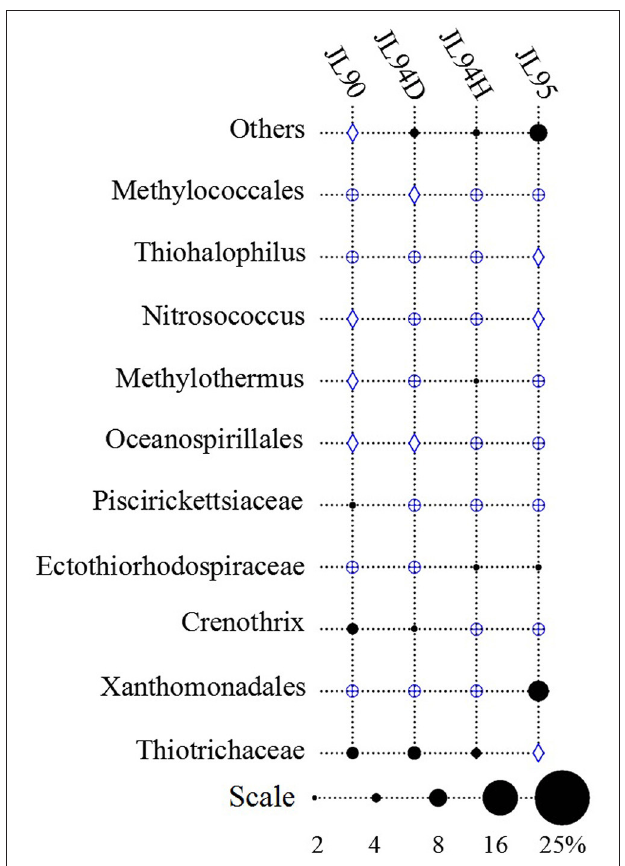
FIGURE 5 | Relative abundance of Gammaproteobacteria taxa observed in each chimney sample for Longqi field at SWIR. “others” represents the less abundant genera of Acinetobacter, Sedimenticola, Marinicella, Colwellia, Arenicellaceae, Marine methylotrophic Group 2, Coxiella, Granulosicoccus, and unclassified Gammaproteobacteria. Groups which were detected below1% are indicated with a blue oplus, between 1 and 2% are indicated with a blue diamond.